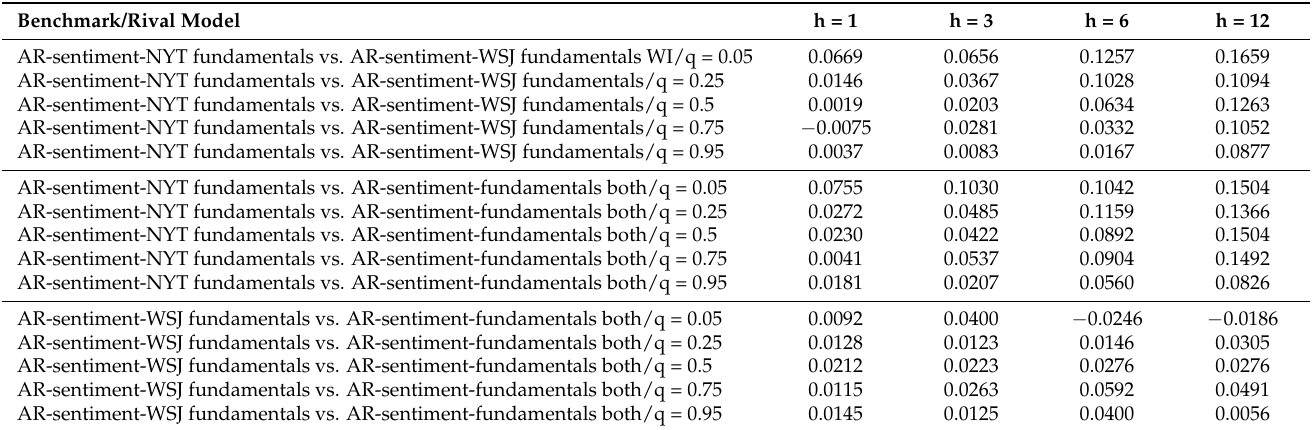
Table 3. The role played by fundamentals: NYT fundamentals vs. WSJ